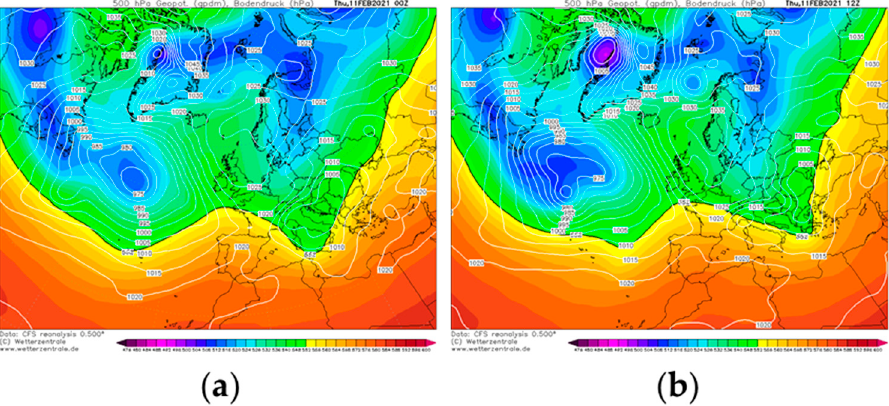
Figure 10. ( a ) Geopotential height at 500 hPa (shaded color) and sea level pressure (white solid line) fields at 00:00 UTC on 11 February 2021. ( b ) Geopotential height at 500 hPa (shaded color) and sea level pressure (white solid line) fields at 12:00 UTC on 11 February 2021 and 12:00 UTC. Both fields were retrieved from Climate Forecast System Renalysis of the National Centers for Environmental Prediction.